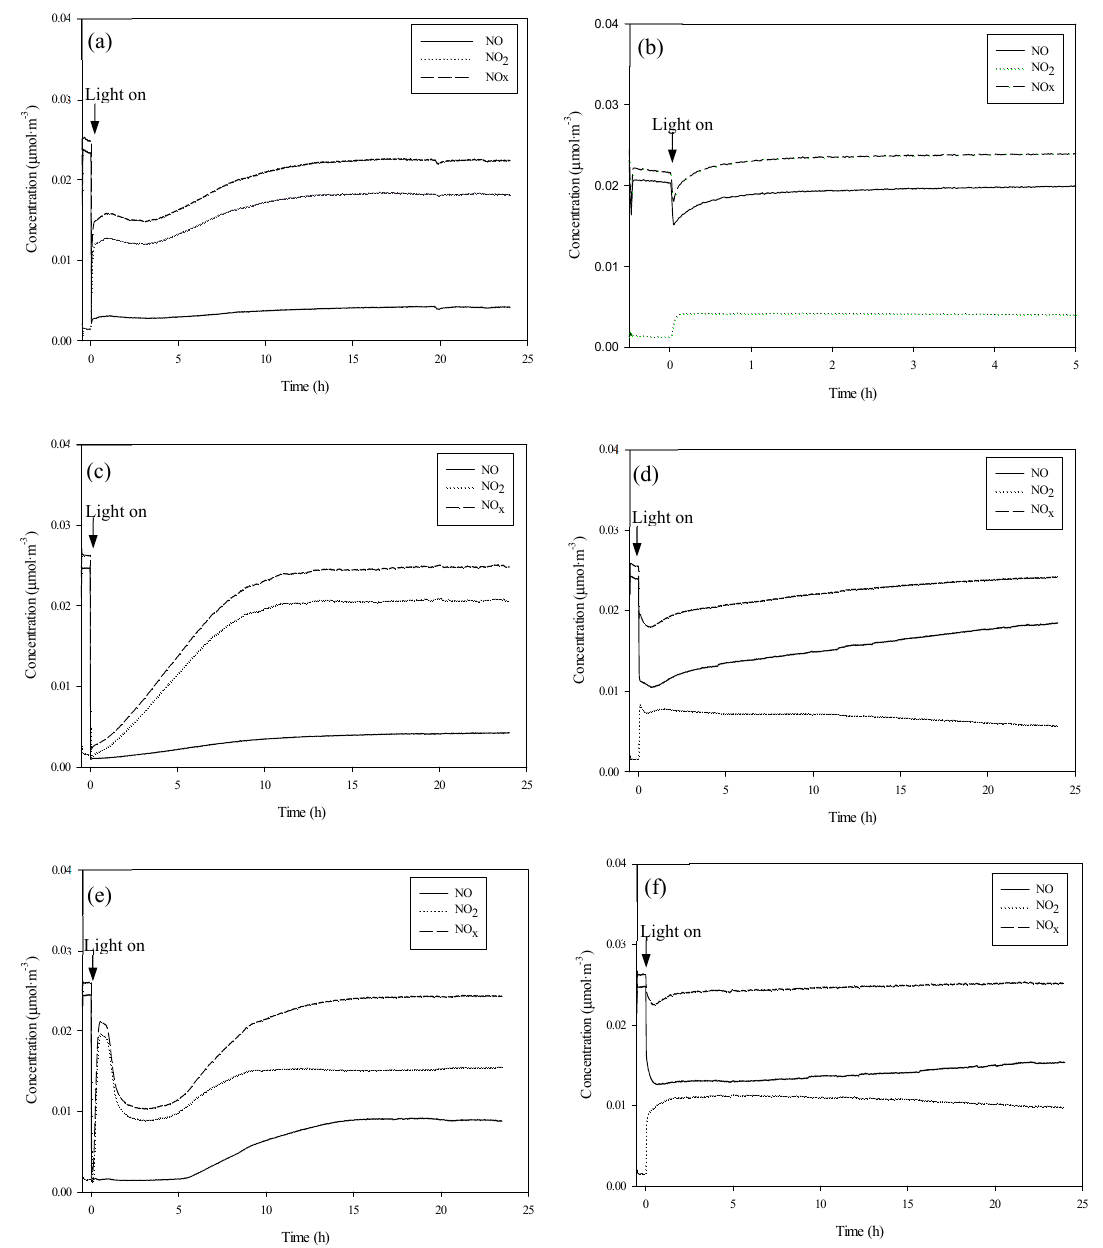
Figure 7. Evolution of species (65% RH): P25 UV-vis ( a ), P25 Vis ( b ), Pd-P UV-vis ( c ), Pd-P Vis ( d ), Pd-I UV-vis ( e ) and Pd-I Vis ( f ).